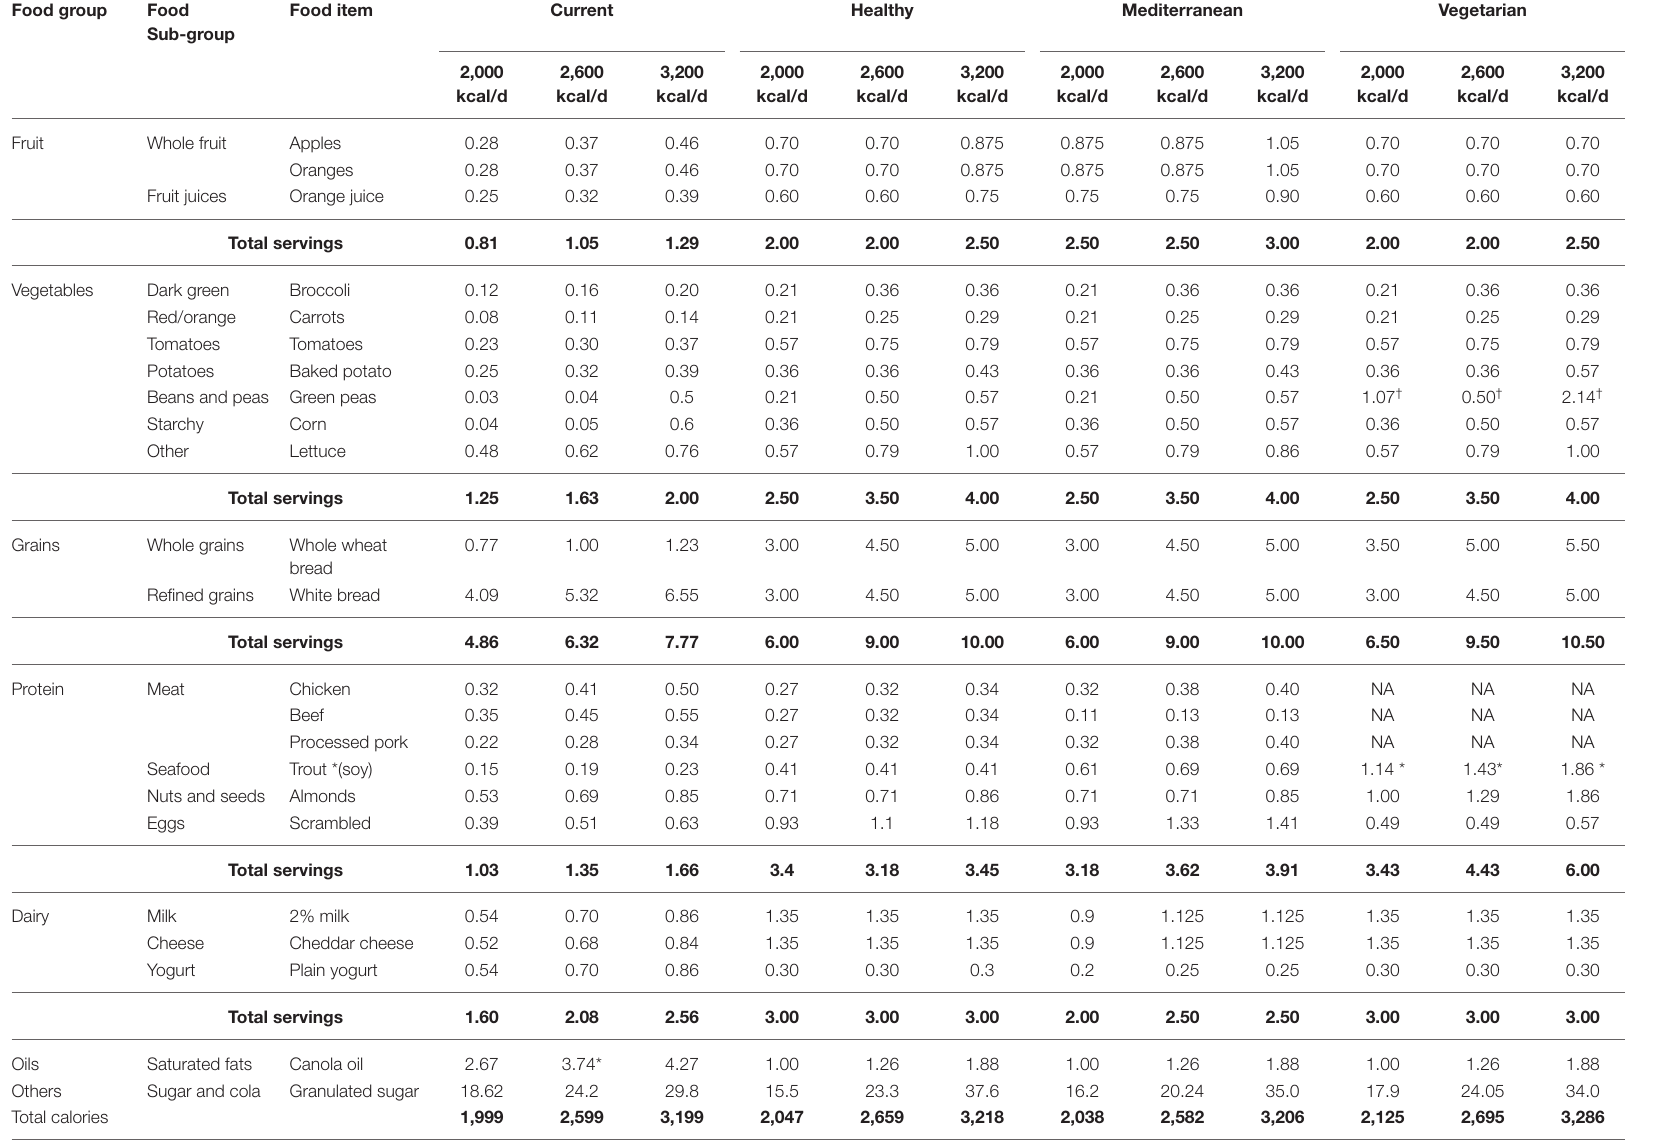
TABLE 1 | Servings per food group for the current diet and three recommended diet patterns at three caloric intake-levels. Food